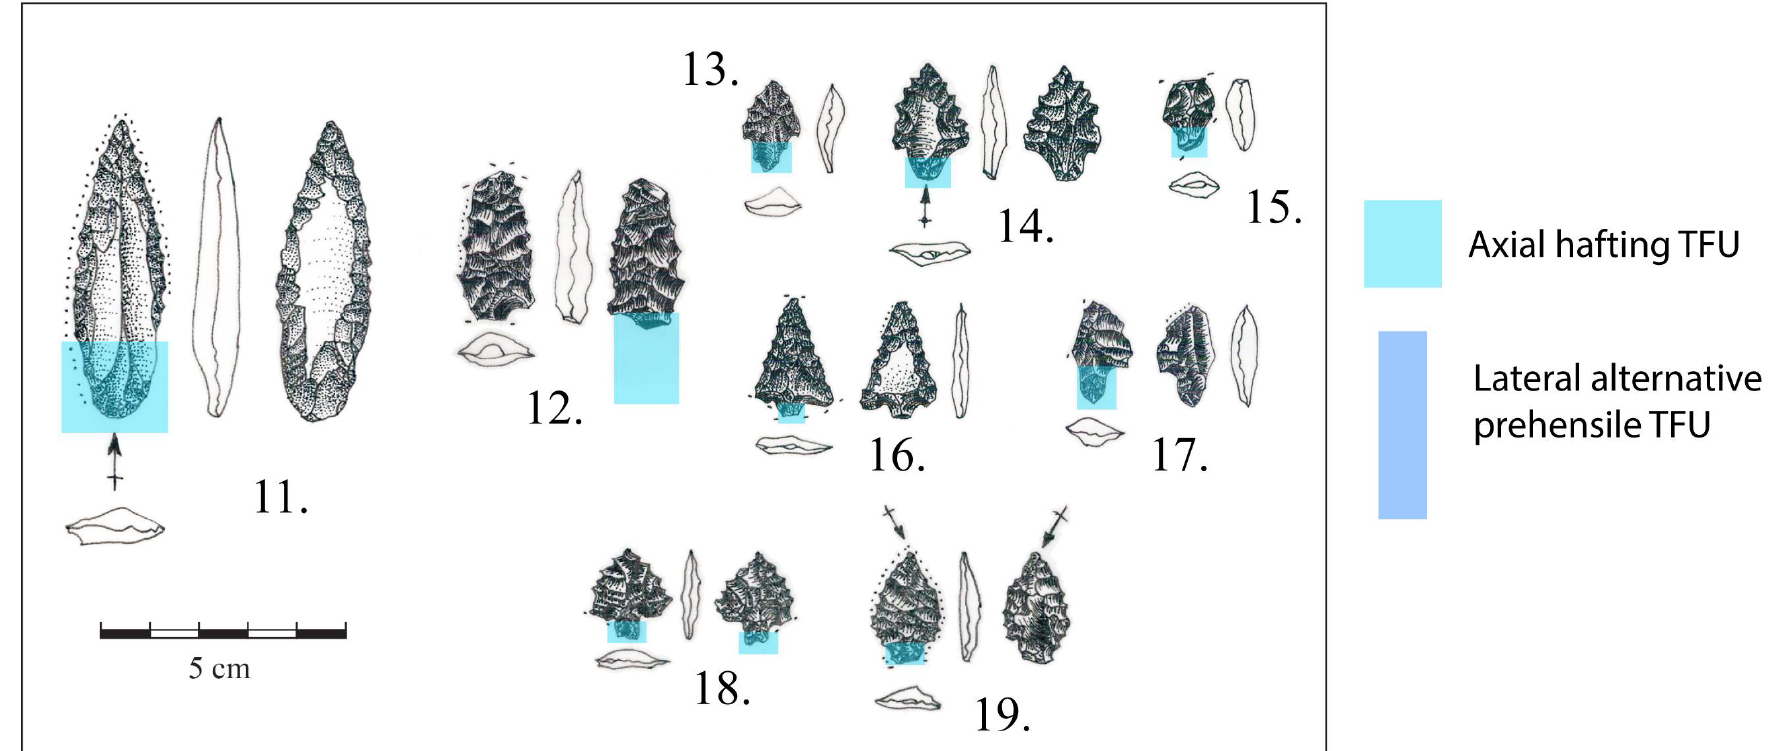
Figure 6. Arrowhead and their prehensile modes in Morro